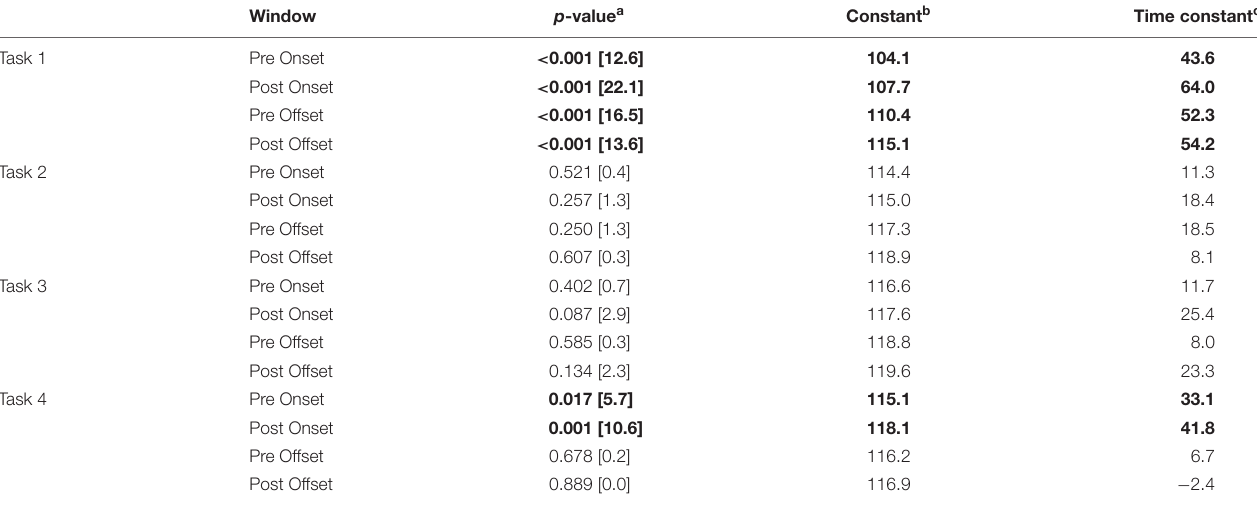
TABLE 5 | Linear regression analysis of temporal trends in heart rate for each task phase.